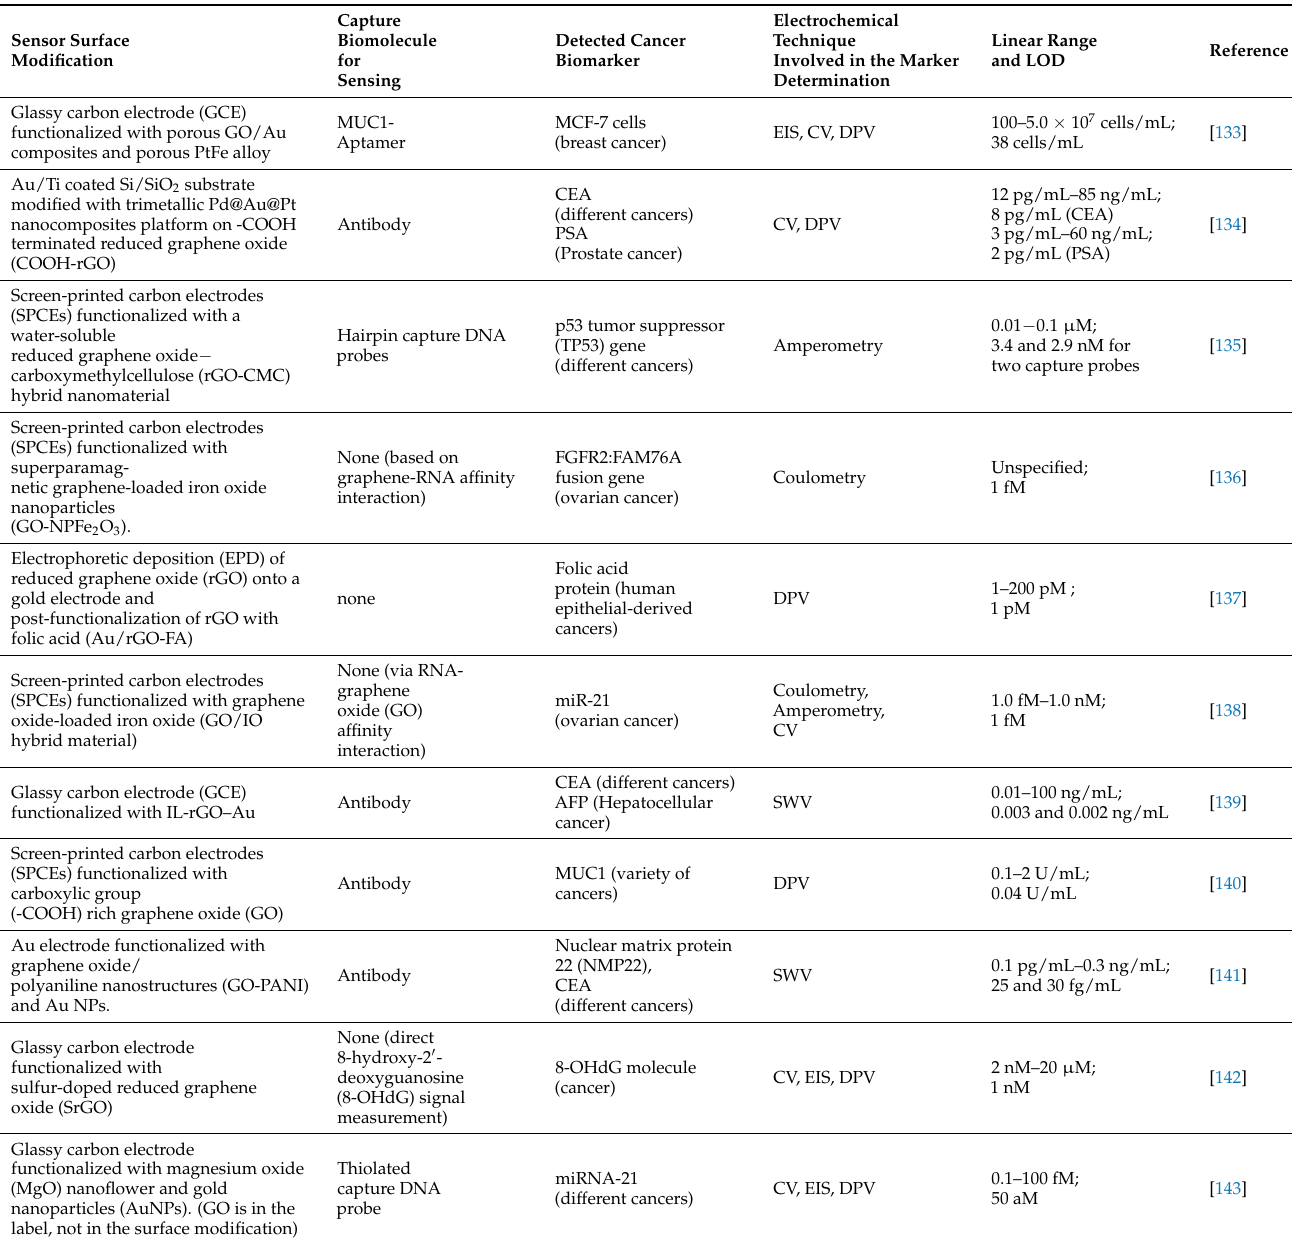
Table 1. Label/redox mediator/indicator-based graphene oxide containing electrochemical biosen- sors for cancer